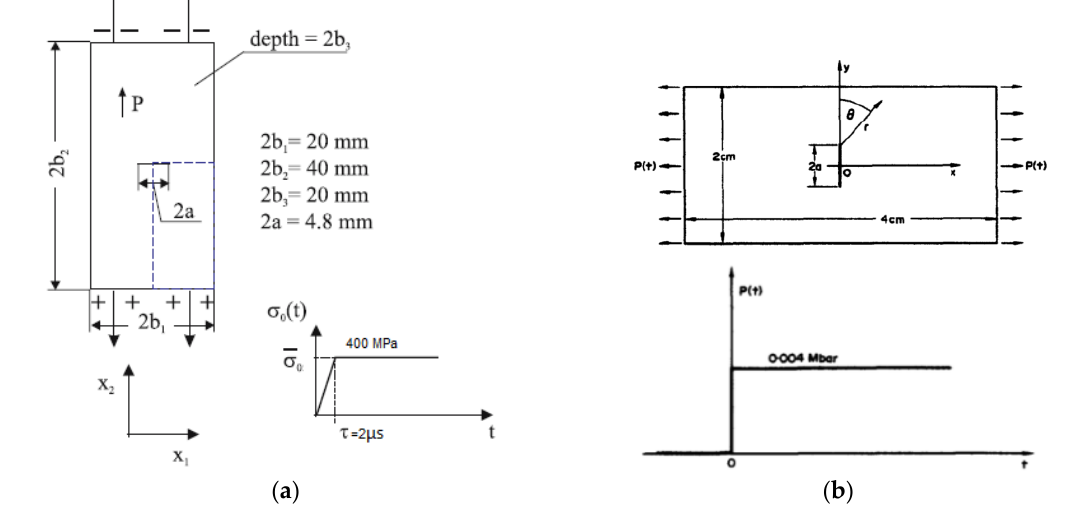
Figure 1. Schematic of the ( a ) piezoelectric (BaTiO 3 ) plate [26] and ( b ) steel plate [27].